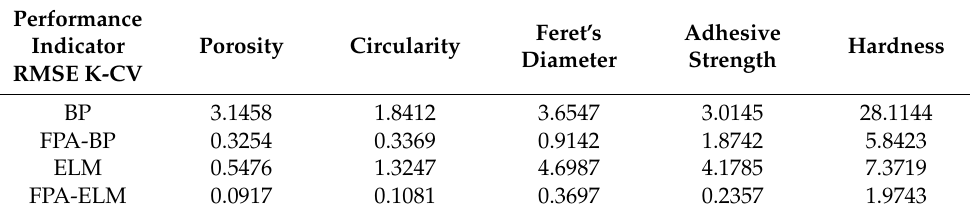
Table 4. The RMSE prediction comparison results of the five parameters of the BP, FPA-BP, ELM and FPA-ELM model obtained by 6-fold